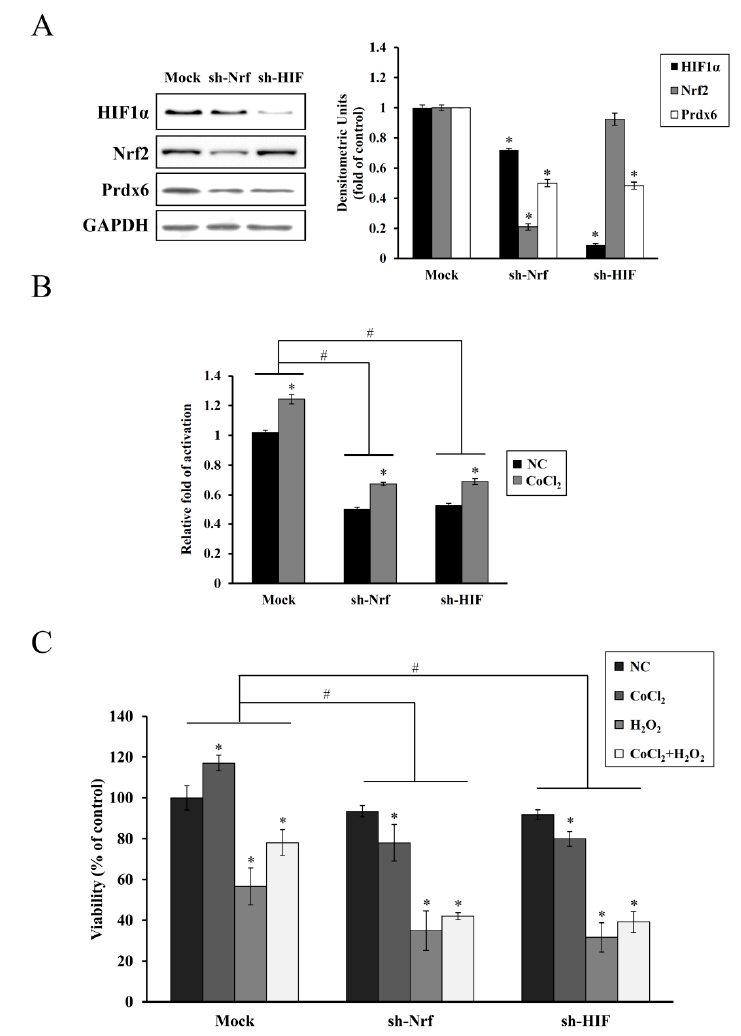
Figure 5. Inhibitory e ff ect of Nrf-2 and HIF-1 α knockdown on Prdx6 expression and preconditioning induced by CoCl 2 . ( A ) HEI-OC1 cells transfected with the pLKO.1(mock), pLKO-mNrf-2 (sh-Nrf), or pLKO-mHIF-1 α (sh-HIF) were treated with 200 μ M CoCl 2 for 6 h. Next, Nrf-2, HIF-1 α , and Prdx6 expression were analyzed via immunoblotting. Individual bands were quantified densitometrically and normalized to GAPDH. Values in the graph are presented as fold changes relative to the mock transfectant, expressed as means ± SDs of three independent experiments (* p < 0.05, compared with the mock control) ( B ) Cells were cotransfected with the pGL3-mPx luciferase reporter vector and each KD plus the β -galactosidase plasmid. After 24 h, cells were treated with 200 μ M CoCl 2 for 6 h, and luciferase activities were determined. Luciferase activities were normalized to that of β -galactosidase. Data are presented as means ± SDs for three independent experiments, expressed as a fold change relative to the mock transfectant. * p < 0.05, compared with the untreated control (NC), # p < 0.05, mock group versus sh-Nrf or sh-HIF group. ( C ) Cells transfected with mock or each KD plasmid were treated with 200 μ M CoCl 2 for 6 h, 25 μ M H 2 O 2 for 9 h, or CoCl 2 plus H 2 O 2 , and cell viability was evaluated using the CCK-8 assay. Data are expressed as a percentage of the mock / untreated control and presented as means ± SDs for three independent experiments. * p < 0.05, compared with the untreated control (NC), # p < 0.05, mock group versus sh-Nrf or sh-HIF